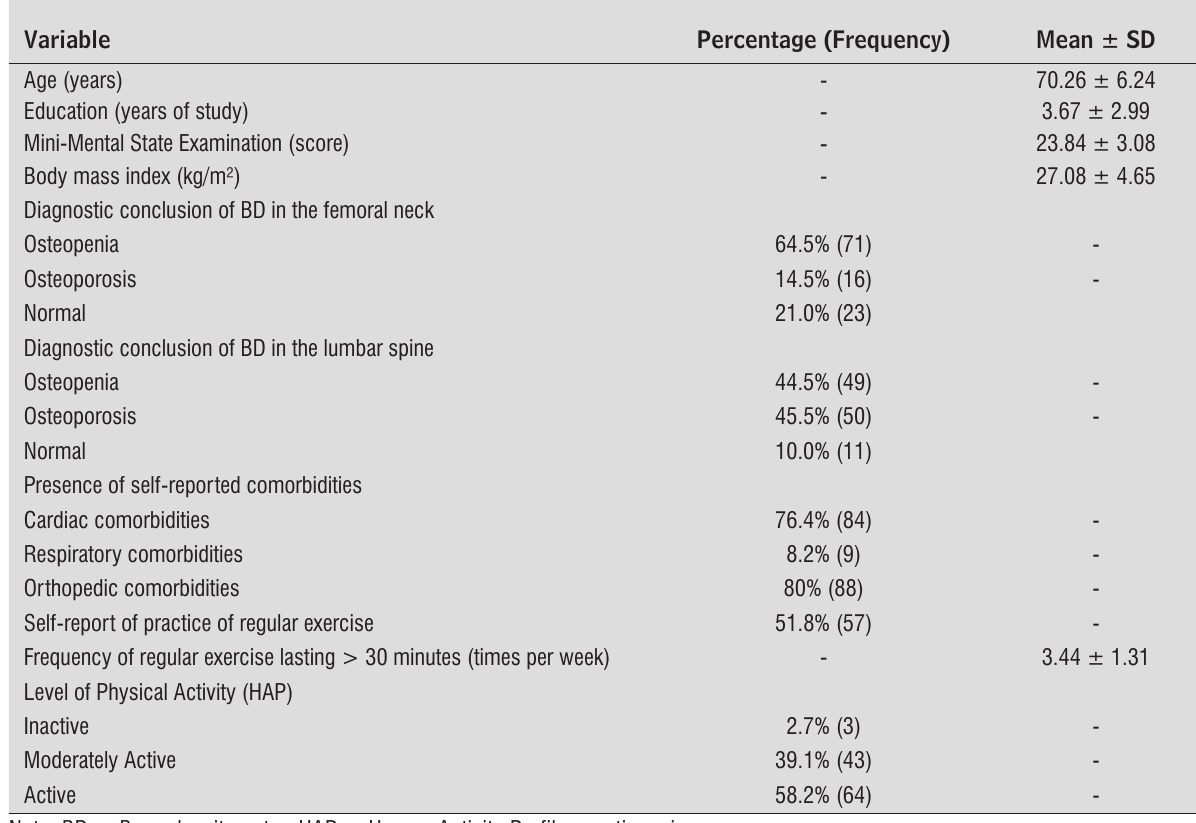
Table 1 - Clinical and sociodemographic characteristics of the volunteers (n = 110) Variable